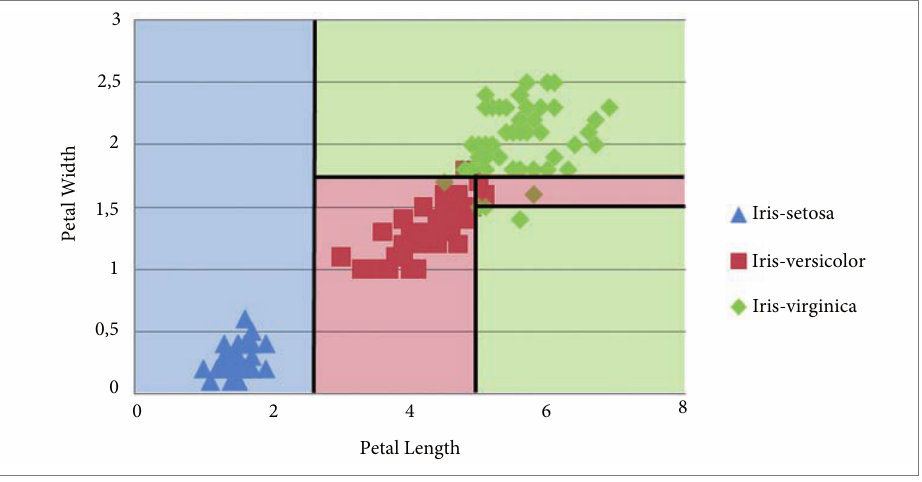
Fig. 4. Three classes of Iris data set classified using CART – Iris-Setosa fully separated at the left-hand part and other two classes overlap still causing